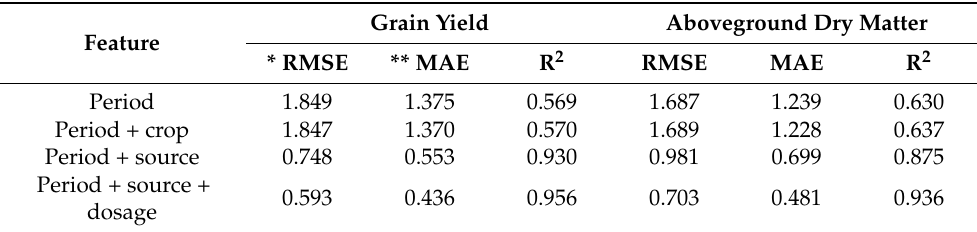
Table 2. Relationships between target variables and features using gradient boosting. Grain Yield Aboveground Dry Matter Feature * RMSE ** MAE R 2 RMSE MAE R 2 Period Period +